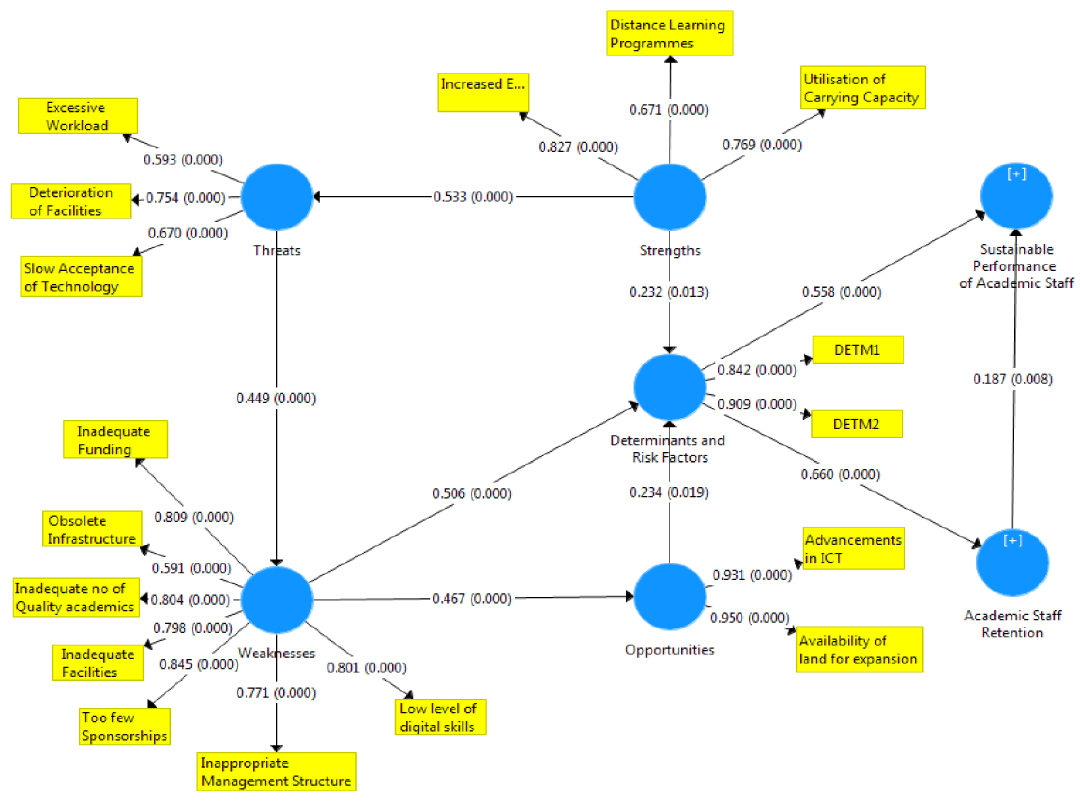
Figure 2. Basic co-efficient algorithms and bootstrapping P-values.